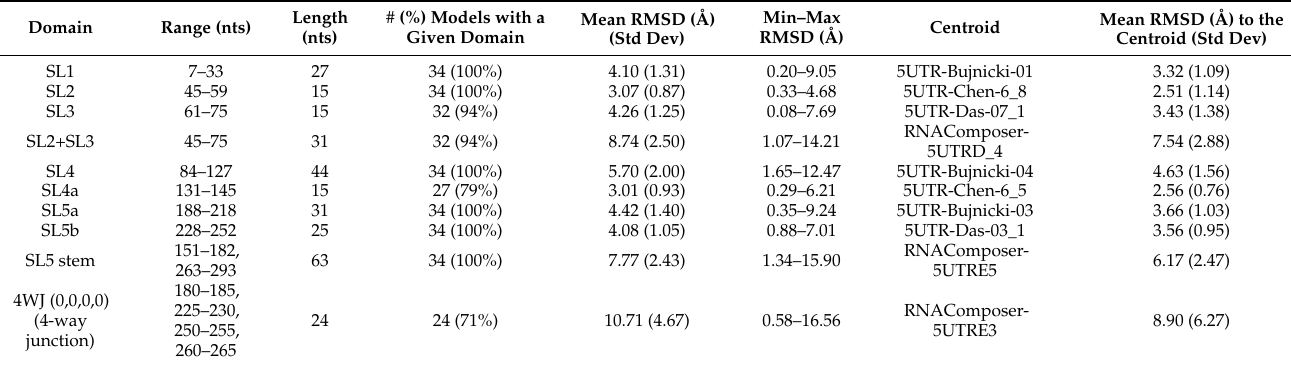
Table 3. Results of the RMSD-based domain analysis in 3D models of 5 (cid:48)